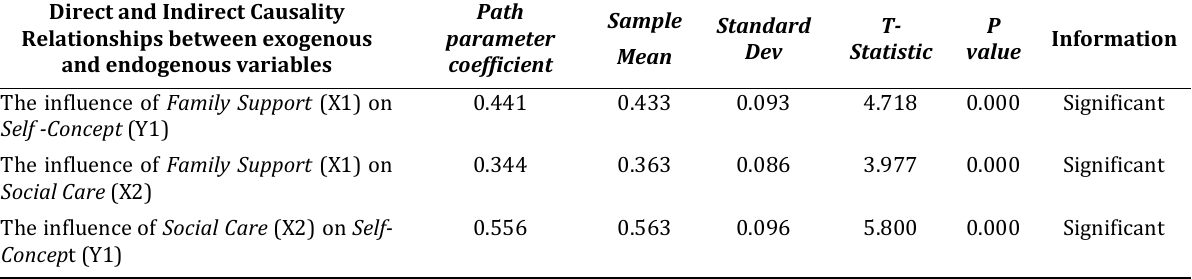
Table 7. T-Statistic Value of Inner Model Self- Concept of Leprosy Patients After Reconstruction Direct and Indirect Causality Relationships between